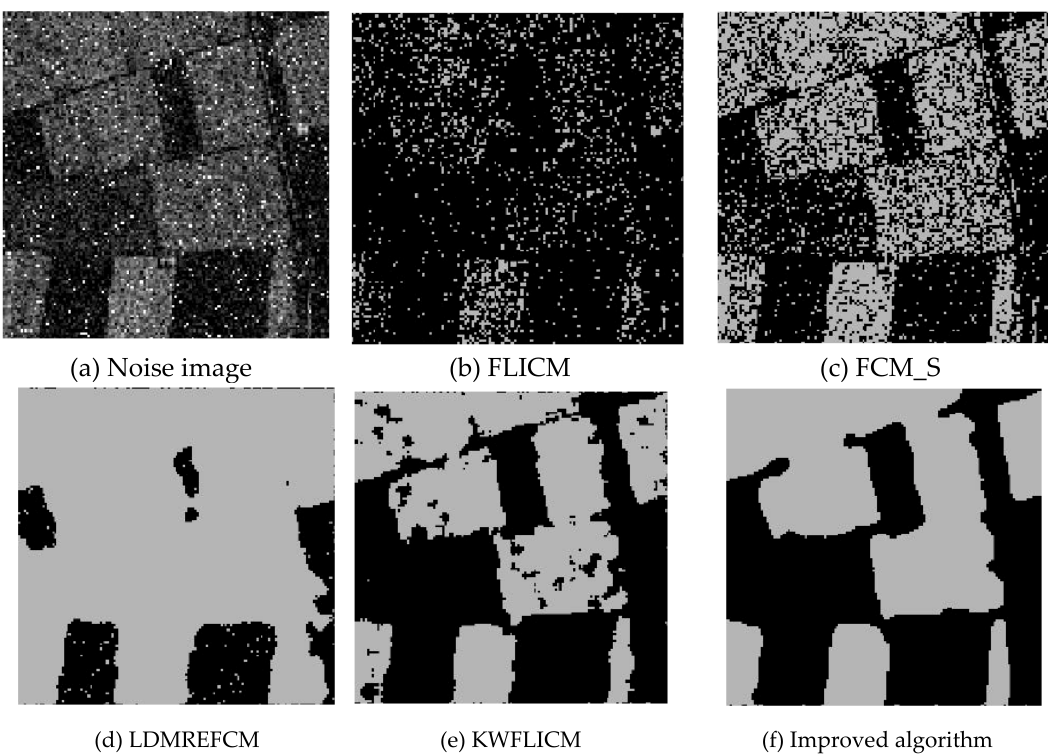
Figure 16. Interference of mixed noise on the farmland image ( a ) and the segmentation results ( b – f ).